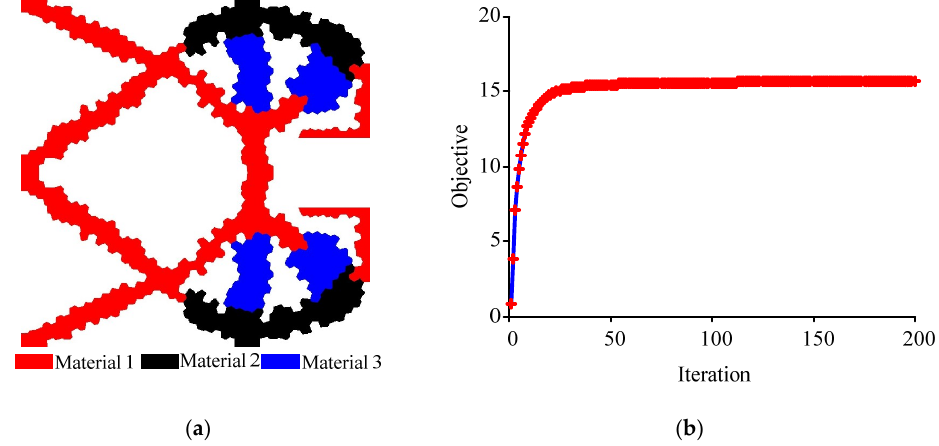
Figure 11. Optimization results of gripper case 2: ( a ) Identifed topologies; ( b ) convergence plot.